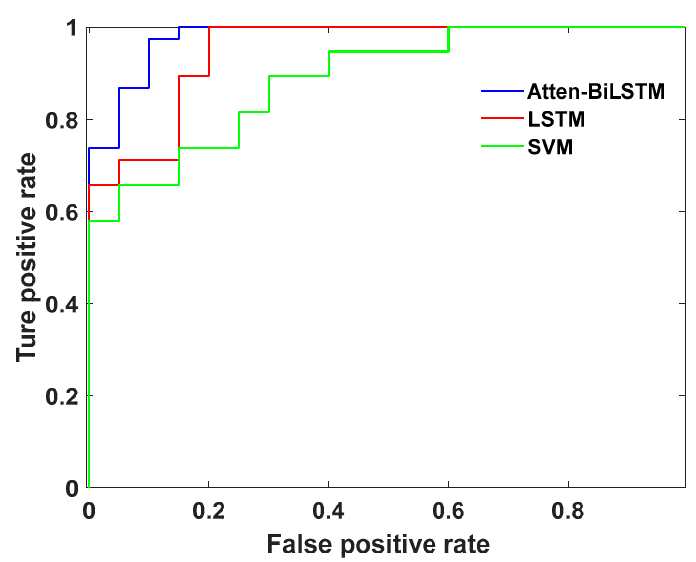
Figure 13. The receiver operating characteristics (ROC) curve for the Atten-BiLSTM model.